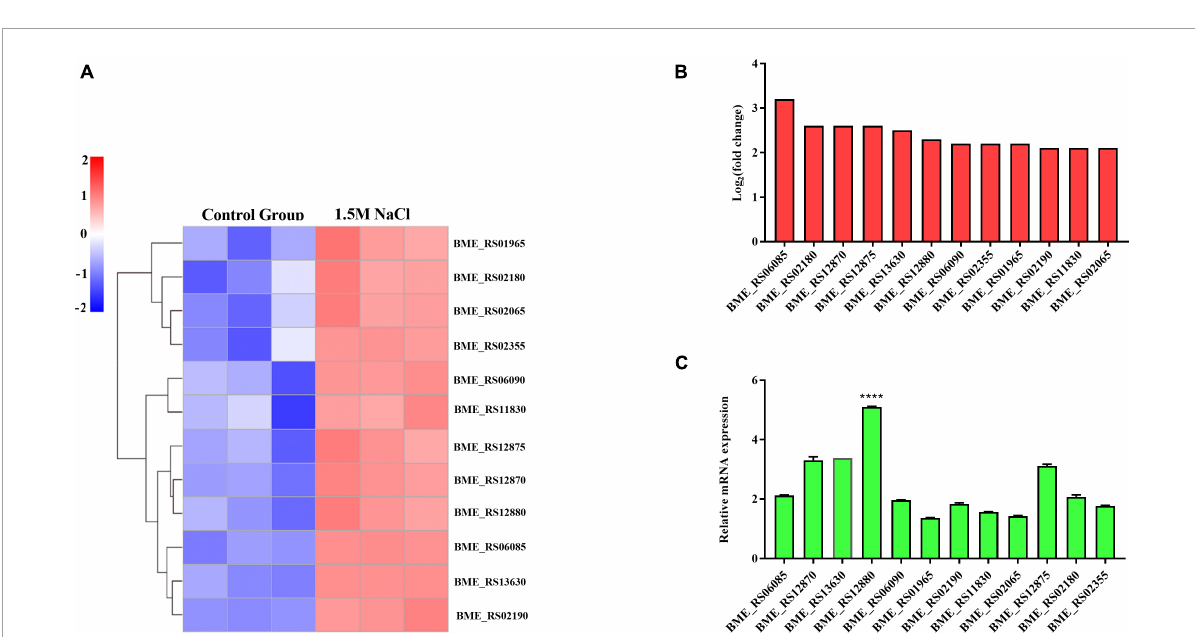
FIGURE5 Differentially expressed genes (DEGs) were evaluated by quantitative reverse transcription PCR (qRT-PCR) assays between the B. melitensis 16M biofilm under 1.5 M NaCl and control conditions. (A) The heatmap shows the expression levels of 12 ABC transporters between the B. melitensis 16M biofilm under 1.5 M NaCl and control conditions. (B , C) The 12 ABC transporters expression levels were further detected by qRT-PCR. The results at each time point are expressed as the means ± standard deviations from at least three independent experiments. One-way ANOVA was used followed by Dunnett’s test to assess significance. **** P ≤ 0.0001.